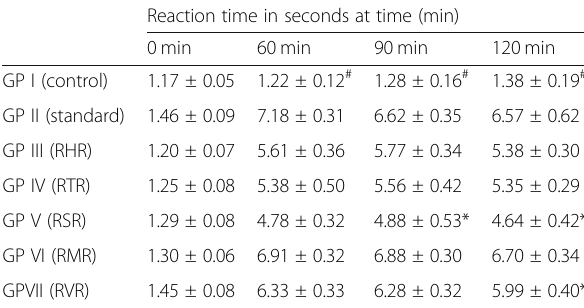
Table 8 Analgesic activity of various Rauvolfia species by hot plate